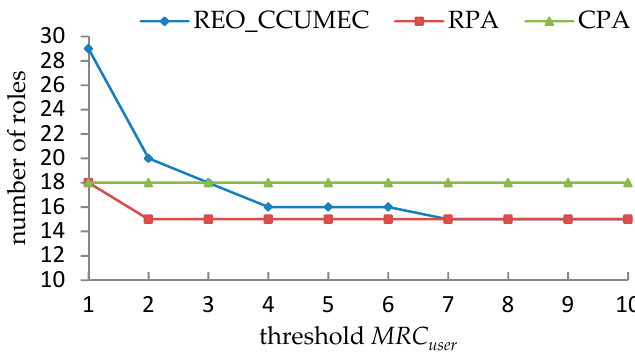
Figure 4. Performance comparison under the UCC in Healthcare.